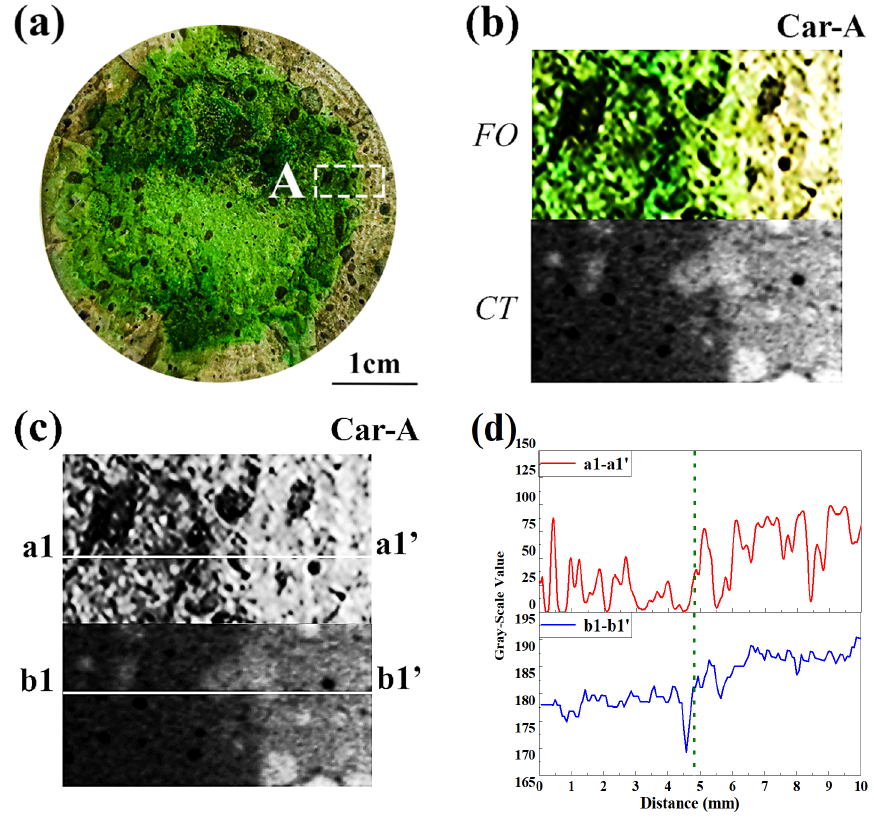
Figure 8. Partly carbonated specimen. ( a ) Cross-section sprayed with F. orchid indicator; ( b ) magnified local image of A and related CT image; ( c ) Binarized image of ( b ); ( d ) 1D distribution of grayscale value along a1-a1 ′ and b1-b1 ′ in ( c ).